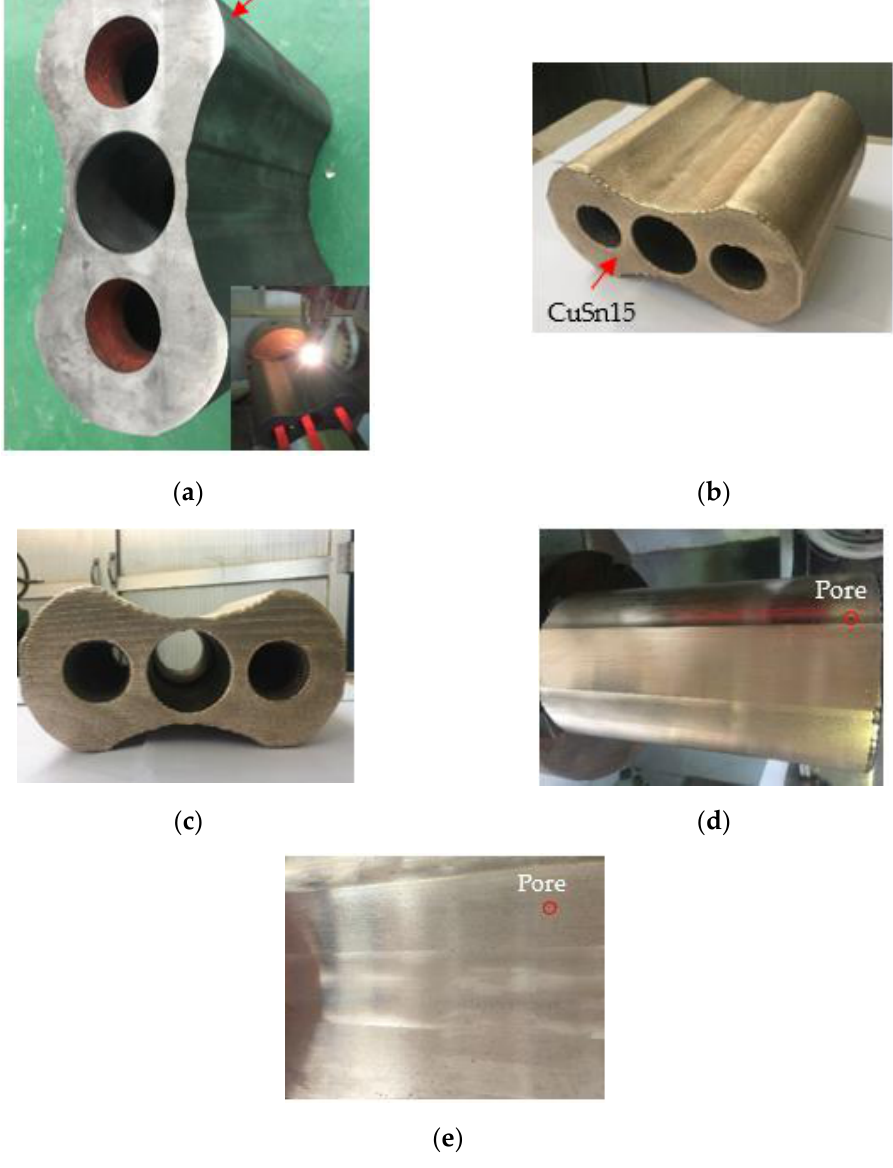
Figure 13. The morphology of the impeller before and after LDED and machining. ( a ) Blank impeller; ( b ) top surface; ( c ) end surface; ( d , e ) surface after machining. Note: Inconel 718 was firstly deposited on the HT250 and then CuSn15 was deposited on the Inconel 718.